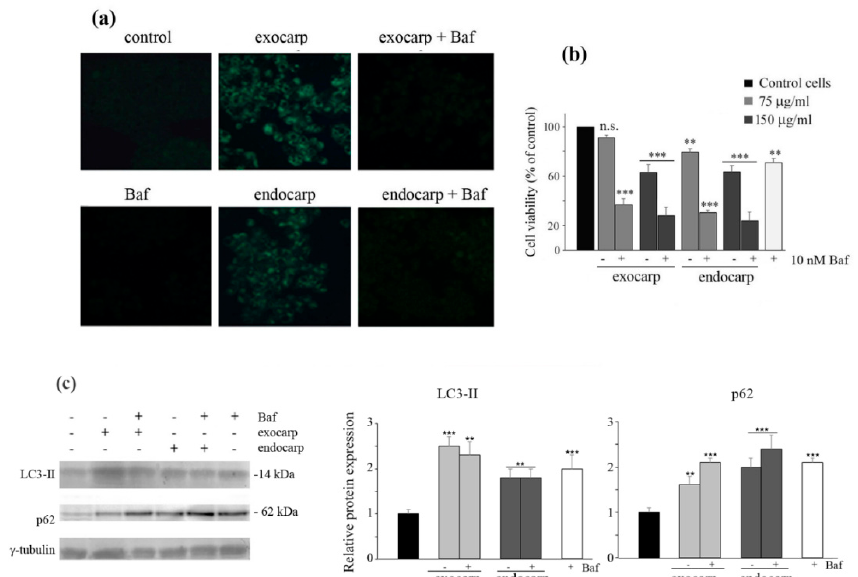
Figure 6. Bafilomycin A1 treatment increases cytotoxic effects of litchi extracts in HT29 cells. ( a ) The efficacy of the autophagy inhibitor bafilomycin A1 (Baf) (10 nM) in preventing autophagy was ascertained by MDC staining as reported in Figure 4. Micrographs are representative of three independent experiments (200 × magnification). ( b ) Cells (7 × 10 3 ) were treated with the indicated doses of litchi exocarp or endocarp extracts either in the presence or absence of bafilomycin A1 for 24 h. Cells were then subjected to an MTT assay as reported in the Materials and Methods. (**) p < 0.01; (***) p < 0.001 compared with control. ( c ) Western blotting of LC3-II and p62 after treatment of HT29 cells with the litchi extracts in the presence or absence of bafilomycin A1 for 24 h. The correct protein loading was ascertained by immunoblotting for γ -tubulin. Representative blots of three independent experiments and densitometric analysis are shown. (**) p < 0.01; (***) p < 0.001 compared with control.